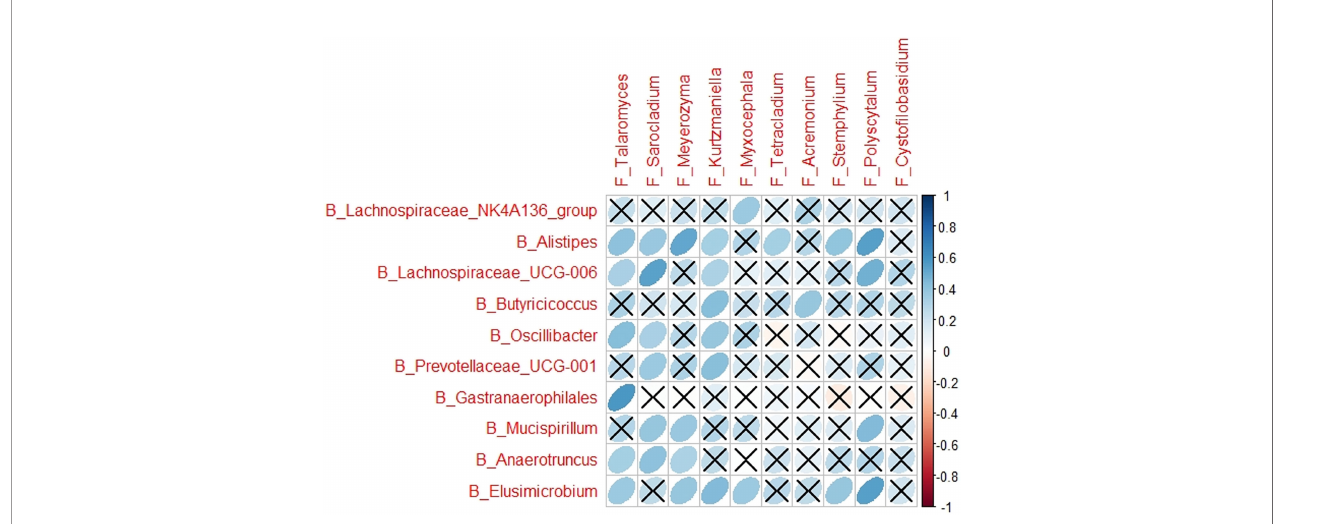
FIGURE 11 | The correlations between bacteria and fungi in the CP1_LI10